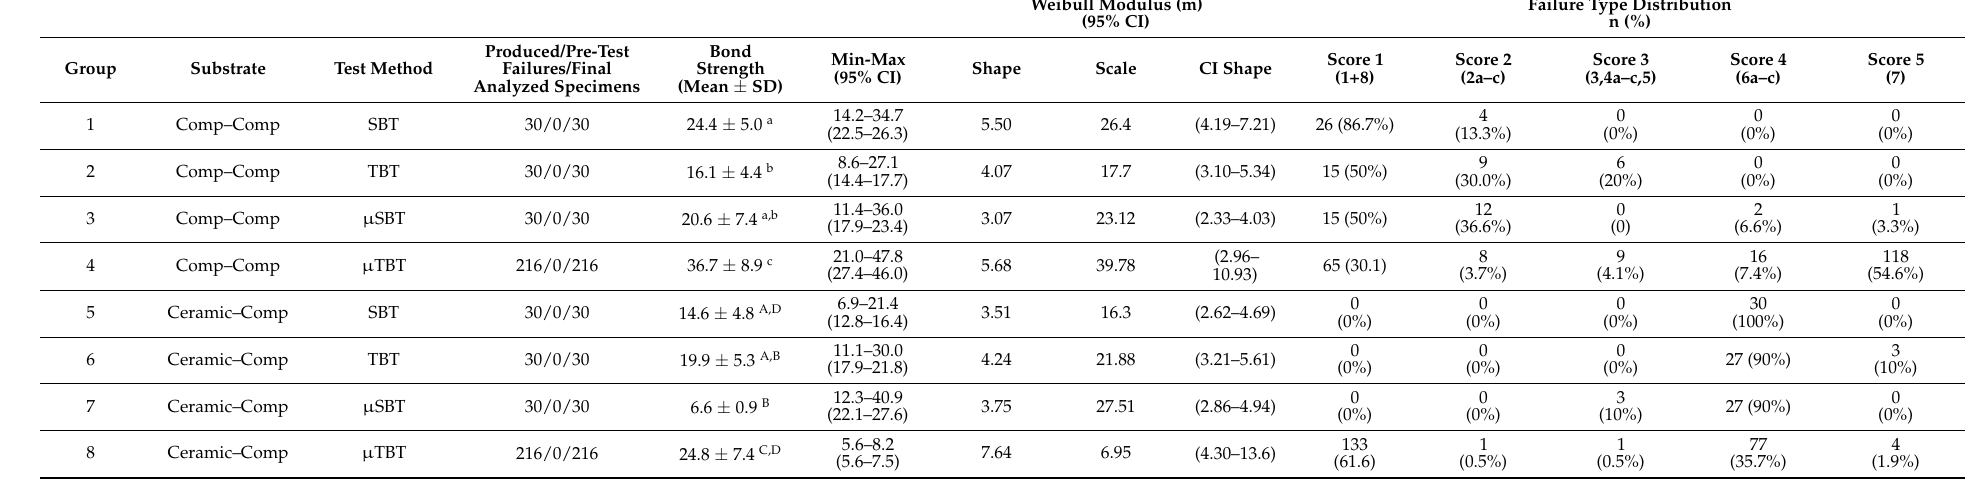
Table 2. Mean bond strength values (MPa ± standard deviations) of all 4 test methods (SBT; TBT; µ SBT; µ TBT), distribution, and frequency of failure types, Weibull modulus. Failure types were classified as follows: Score 1: cohesive1: cohesive failure in the substrate; Score 2: mixed1: a combination of adhesive and cohesive failure types in the substrate and bonding agent; Score 3: adhesive: adhesive failure of bonding agent from the resin composite surface with no remnants on the resin composite; Score 4: mixed2: a combination of adhesive and cohesive failure types in the bonding agent and resin composite; Score 5: cohesive2: cohesive failure in the resin composite. The same superscript lowercase letters in the same column indicate no significant differences based on the substrate type, and uppercase letters are based on the test method ( p < 0.05). Test group descriptions are explained in Figure 1. Significantly different bond strengths in comp-comp substrates are marked with the superscripts a, b, c, while significantly different values for Ceramic-comp substrates were distinguished using the superscripts A, B, C and